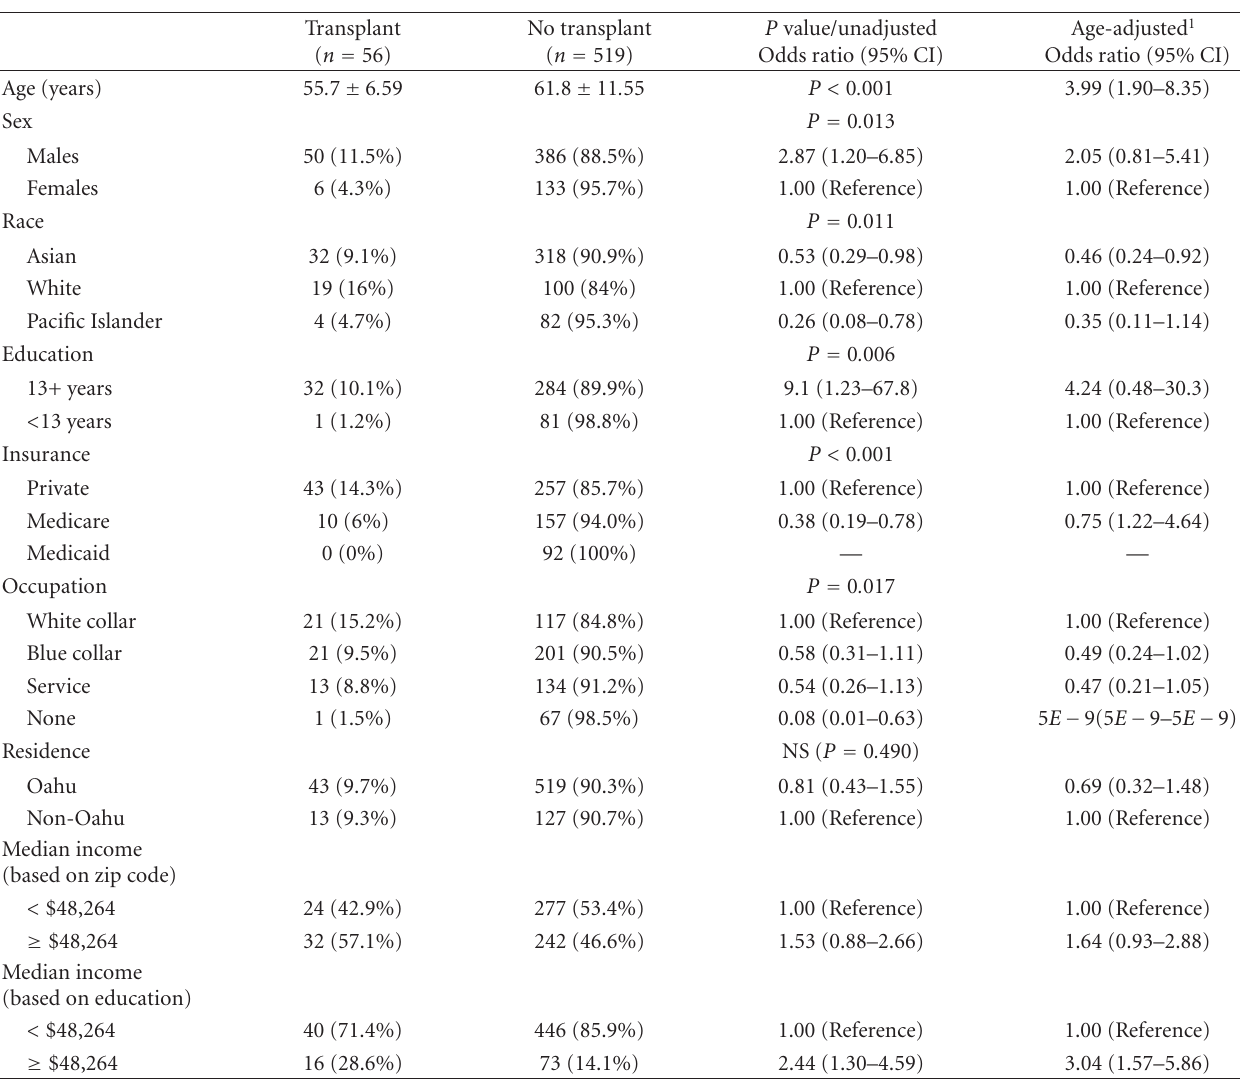
Table 2: HCC patients by liver transplant